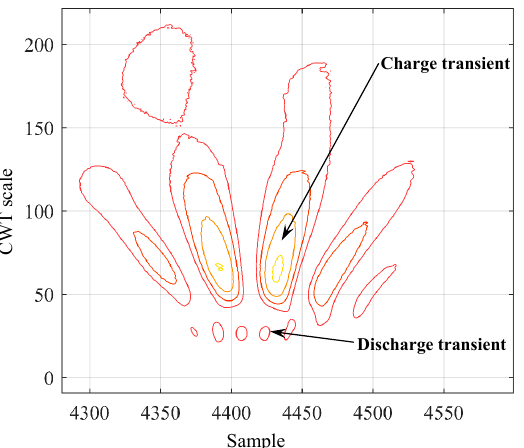
Figure 3. Contour plot of the CWT output from transient current waveform. Energies 2019 , 12 FOR PEER REVIEW